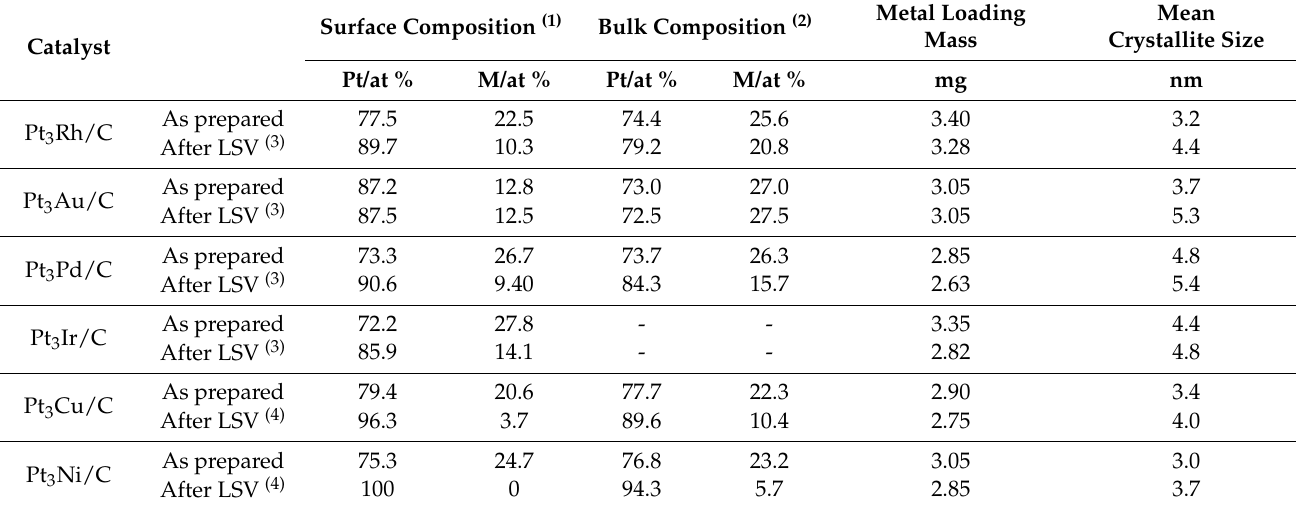
Table 2. Surface composition, bulk composition, metal loading mass and mean crystallite size for Pt 3 M/C (M = Rh, Au, Pd, Ir, Cu and Ni) catalysts as prepared and after the linear sweep voltammetry measurement for electrochemical toluene (TL) hydrogenation.